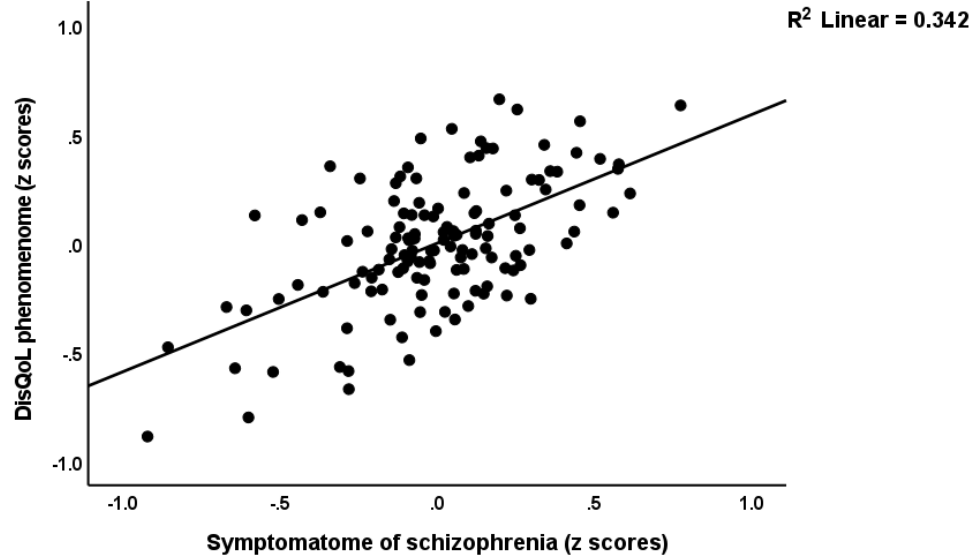
Figure 2. Partial regressions of the DisQol phenomenome, a latent vector extracted from three Sheehan disability (Dis) domains and four WHO-Quality of Life (QoL) domains on the symptomatome of schizophrenia, a latent vector extracted from all symptom domains, after adjusting for the effects of confounders.